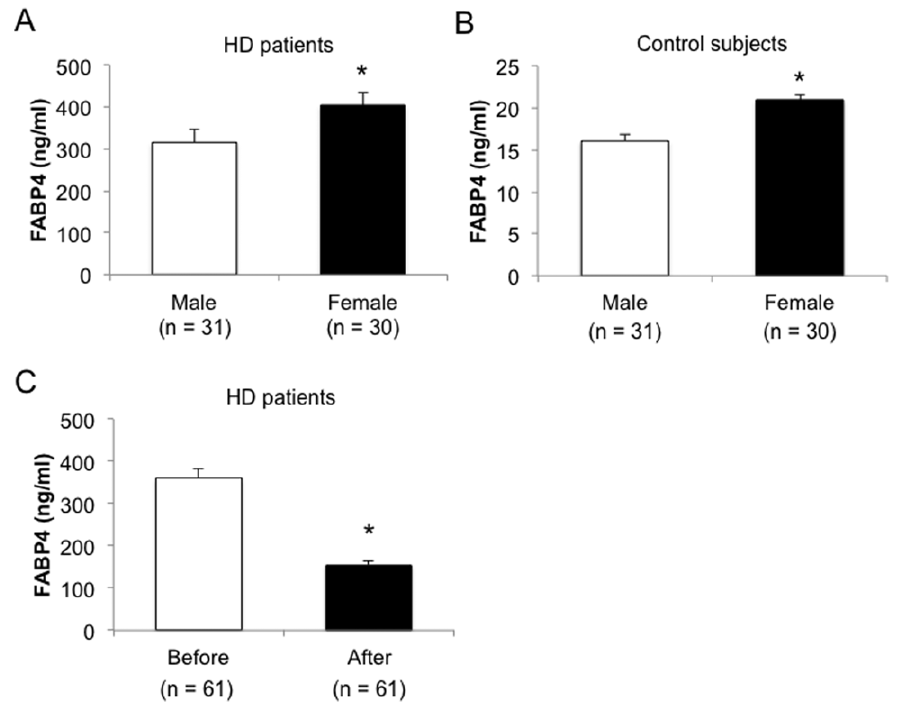
Figure 1. Concentrations of FABP4. FABP4 levels were investigated in the males and females of hemodialysis patients (A) and control subjects with normal renal function (B). FABP4 levels were determined before and after hemodialysis (C). Values are presented as means 6 SEM. *P , 0.05.